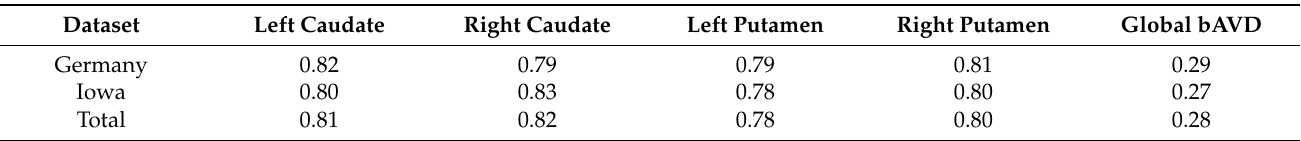
Table 5. DICE and balanced average Hausdorff distance results for caudate-putamen segmentation model. The model performed consistently, with a DICE of around 0.8 and bAVD of 0.28 voxels.